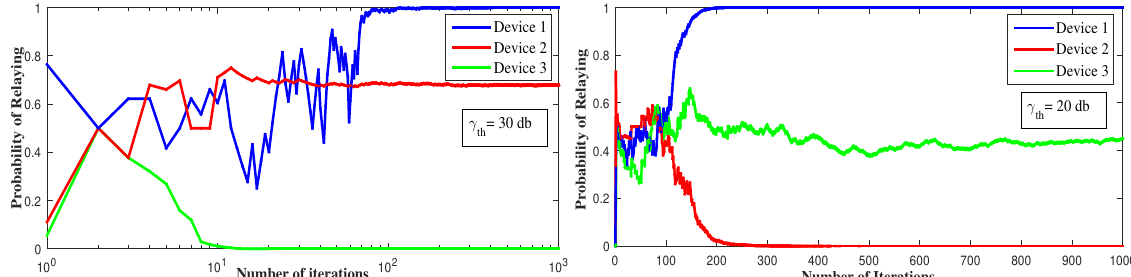
Figure 9. The effect of the SINR threshold ( γ th ) on the convergence to a mixed NE using BG dynamics.